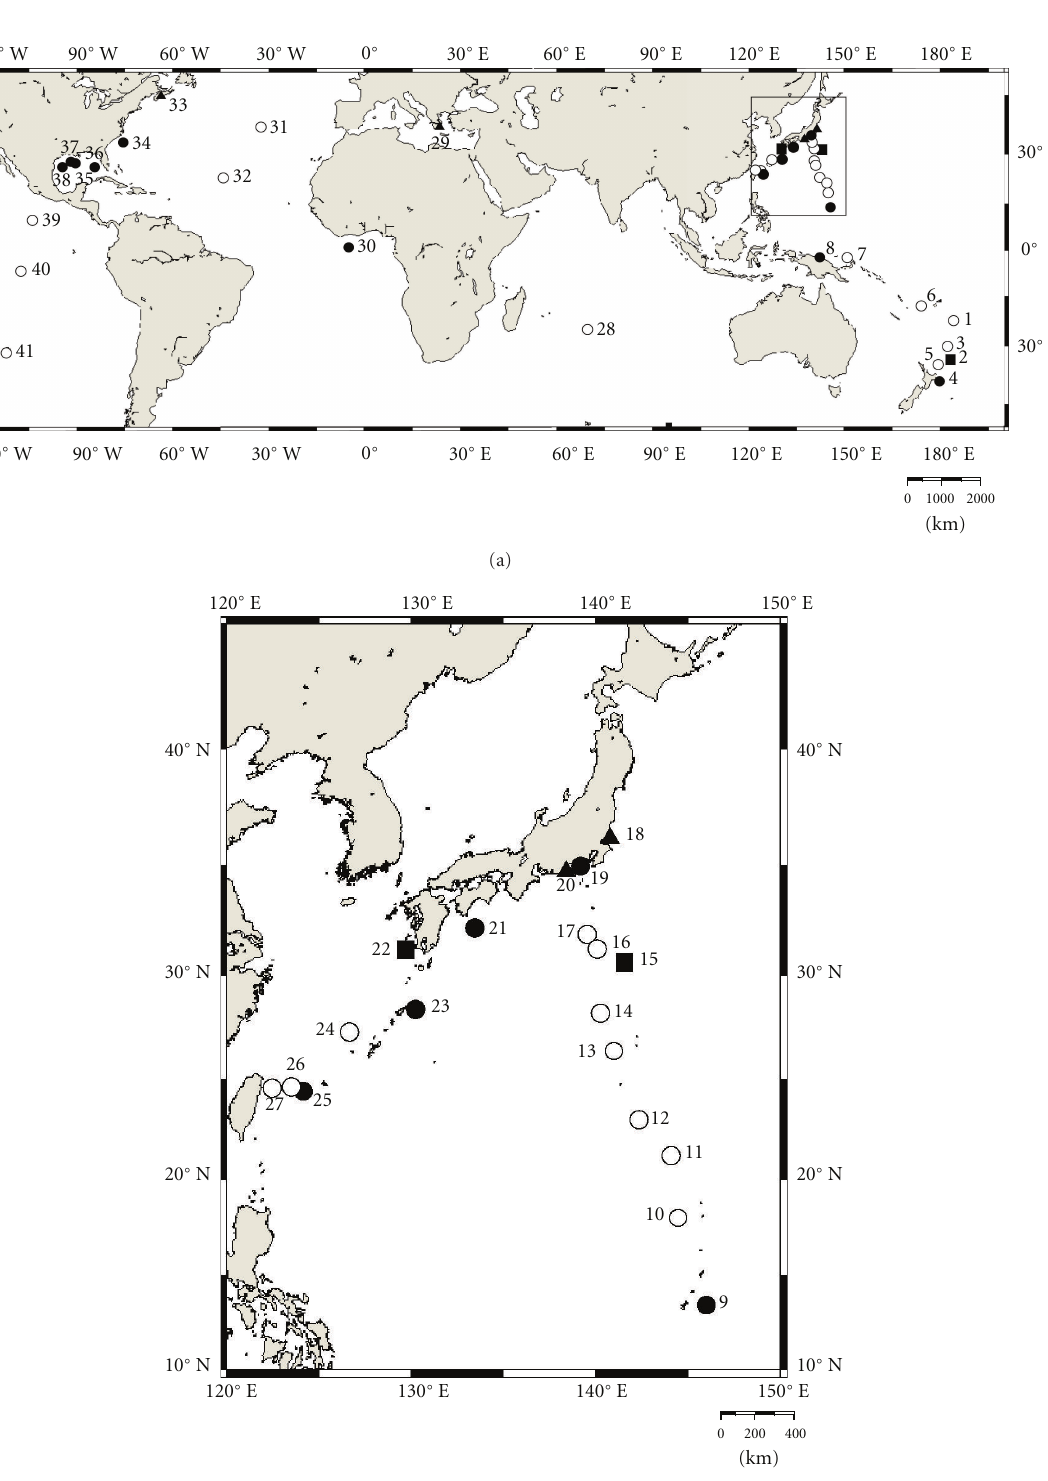
Figure 1: The sampling sites of the deep-sea Bathymodiolus mussels and their relatives used in this study. Refer to Table 1 for the details of the sampling sites (1 to 42). (a) worldwide map; (b) the magnified map showing the areas around Japanese waters. (cid:6) , hydrothermal vent; , cold-water seep; (cid:2) , wood/whale bone; (cid:3) ,